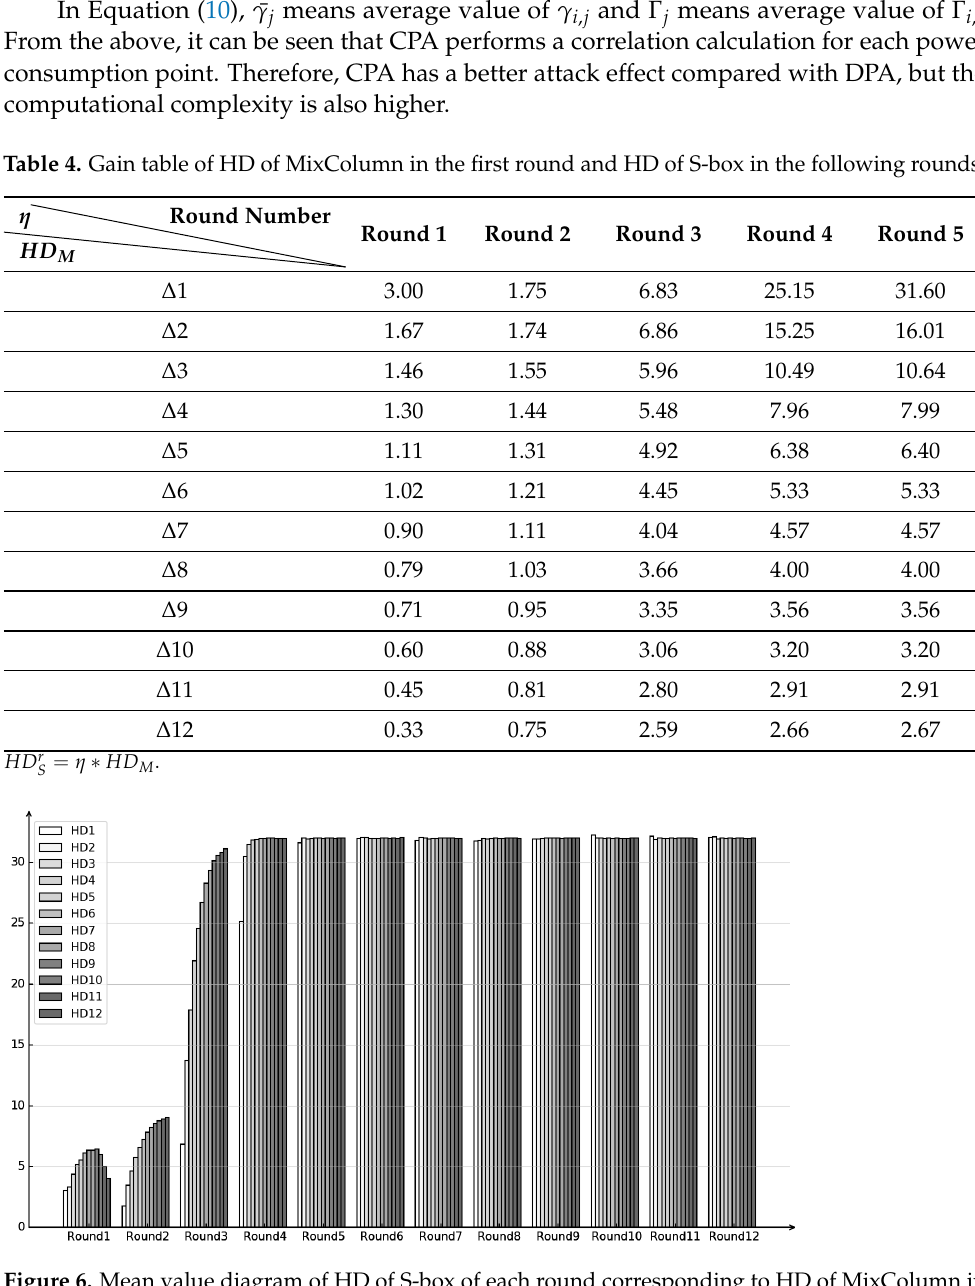
Figure 6. Mean value diagram of HD of S-box of each round corresponding to HD of MixColumn in the first